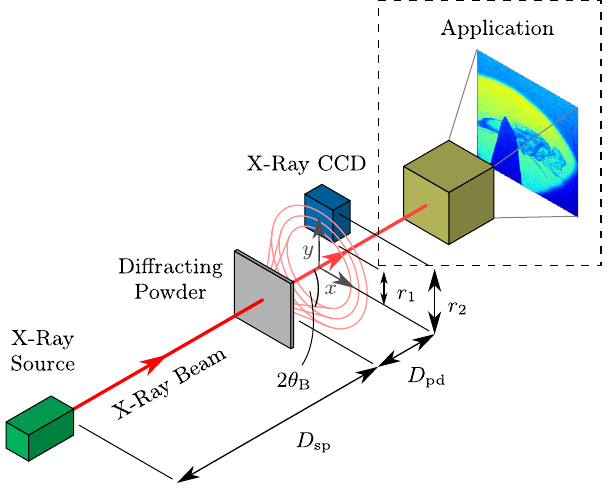
FIG. 1. Geometry of an XCERP diffraction measurement. A broadband x-ray beam is incident normally on a powdered target. Diffraction from the powder sample produces Debye-Scherrer rings with angular radii which vary with photon energy and lattice plane spacing. The distance along the axis from source to powder is D and the distance from powder to detector is D sp distances of the detector ’ s upper and lower edges from the beam axis are r 1 and r 2 , respectively. Most of the x-ray beam is not diffracted and can be used for application such as, in this case, phase-contrast